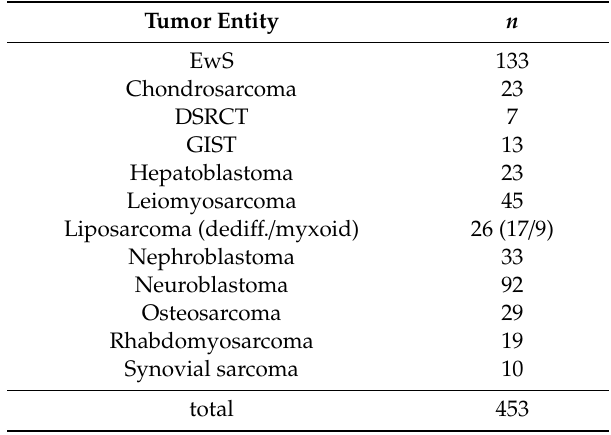
Table 1. Composition of the tissue microarrays (TMAs). EwS, Ewing sarcoma; DSRCT, desmoplastic small round cell tumor; GIST, gastrointestinal stromal tumor; dedi ff , dedi ff erentiated. Tumor Entity n EwS 133 Chondrosarcoma